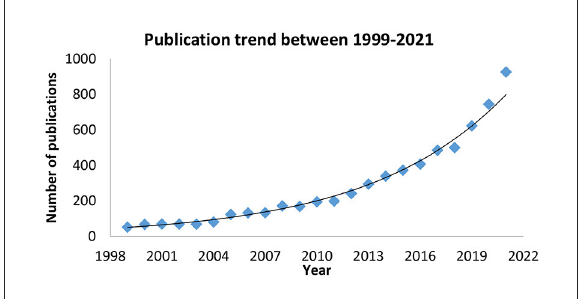
FIGURE2 The number of publications between 1999 and